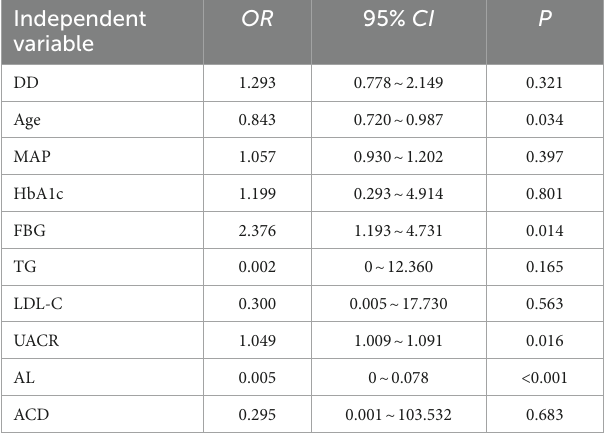
TABLE 4 Multivariate logistic regression analysis of risk factors for